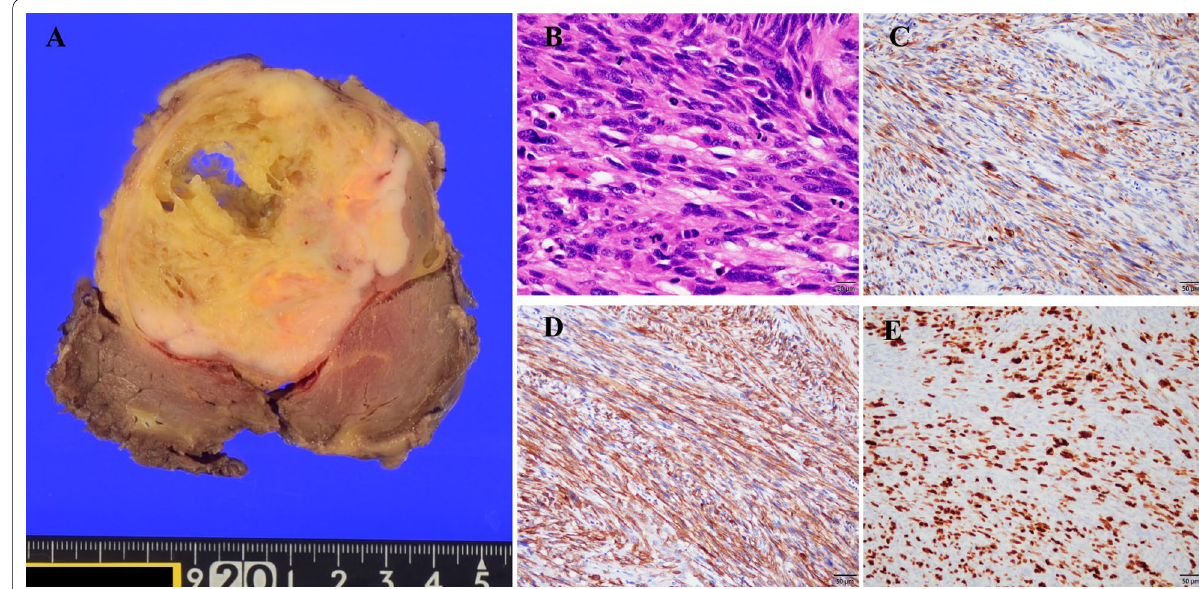
Fig. 2 A Macroscopic appearance of the primary tumor, measuring 15 spindle cells with nuclear pleomorphism and numerous mitotic figures (HE staining, original magnification analysis was positive for desmin (Immunohistochemistry, original magnification (Immunohistochemistry, original magnification